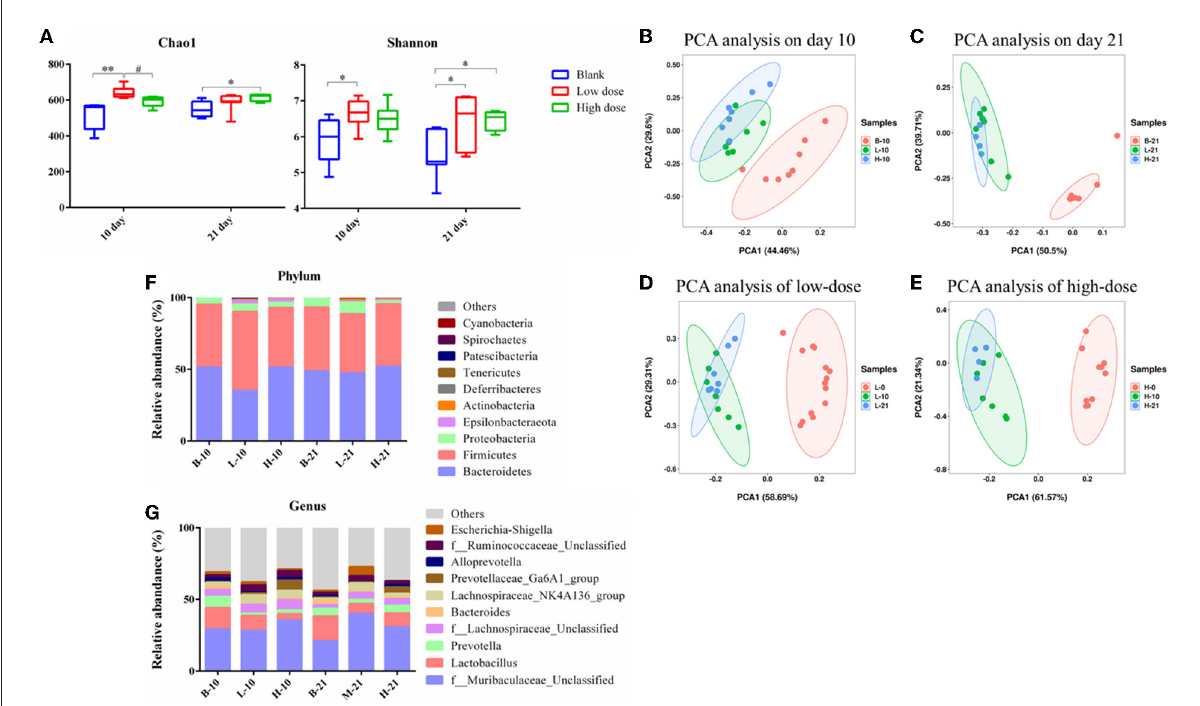
FIGURE6 Gut microbiota analysis of each group. (A) Alpha diversity analysis. (B–E) PCA analysis on the 10th day groups (B) , 21st day groups (C) , low-dose groups (D) , and high-dose groups (E) . (F) Relative abundance of significantly altered taxa at the phylum level. (G) Relative abundance of significantly altered taxa at the genus level. * P < 0.05, compared with the blank groups; ** P < 0.01, compared with the blank groups; # P < 0.05, compared with the low dose groups, n =